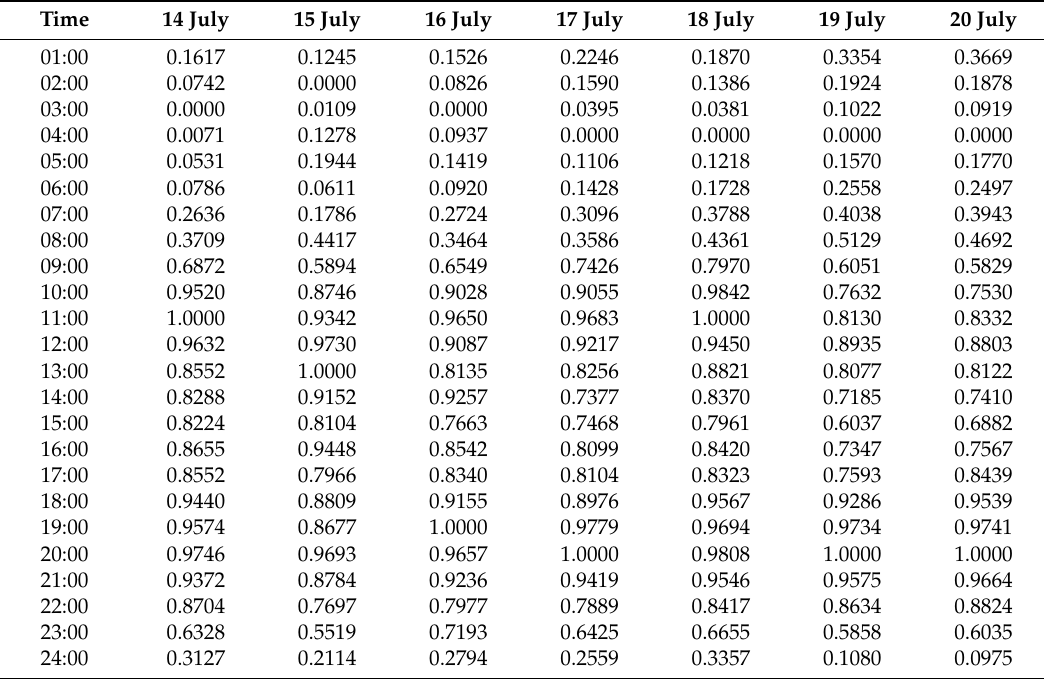
Table 1. Normalization values of load data for IDAS